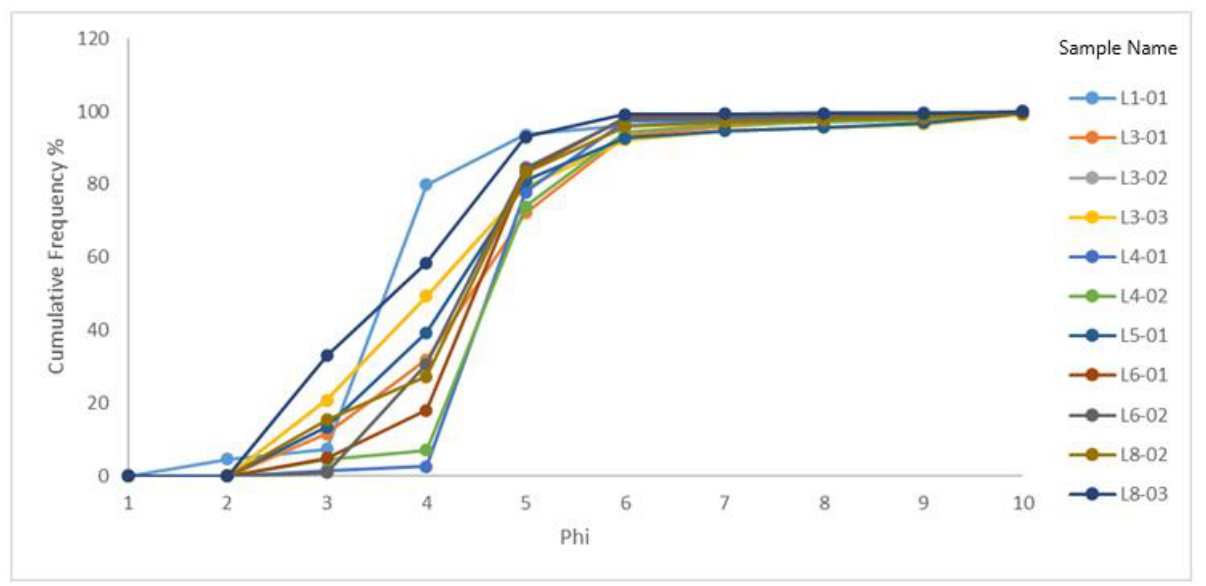
Figure 21. USDA sediment classification [23]. Most of the samples fall into the sand and the loamy sand ranges, mainly controlled by the silt percentage in the sample.